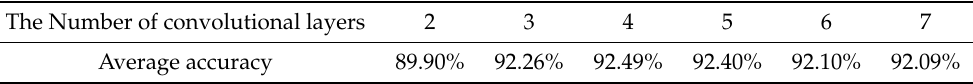
Table 3. Average accuracy by the different number of convolutional layers in Erhai Lake. The Number of convolutional